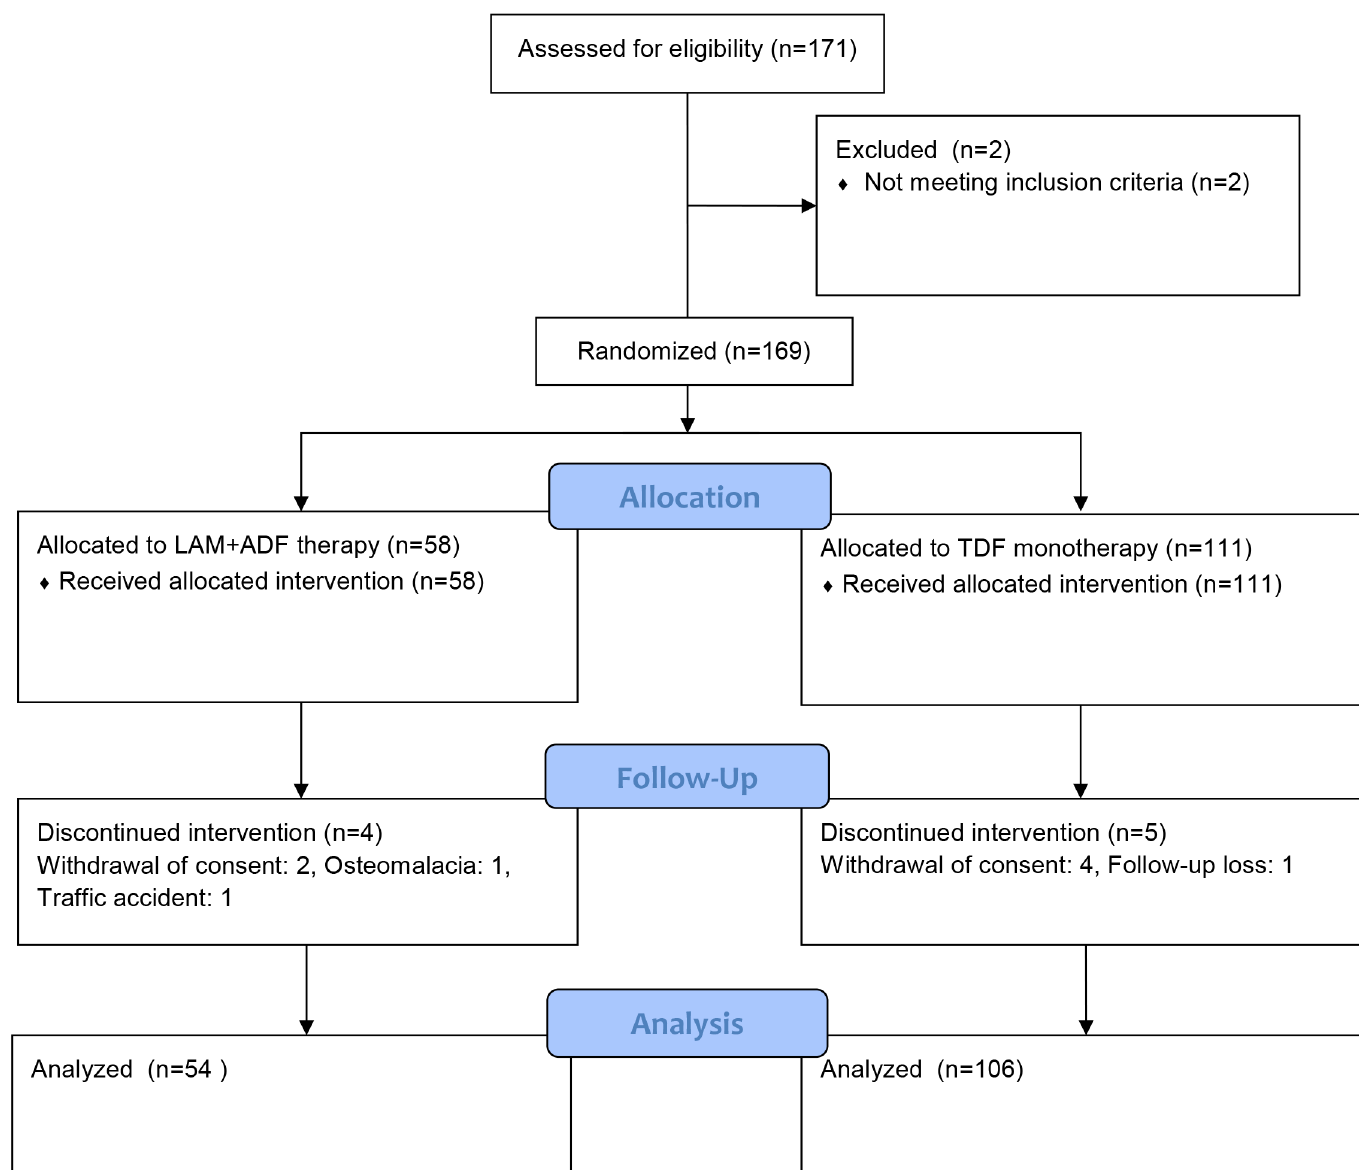
Fig 1. Study design and patient flow for both